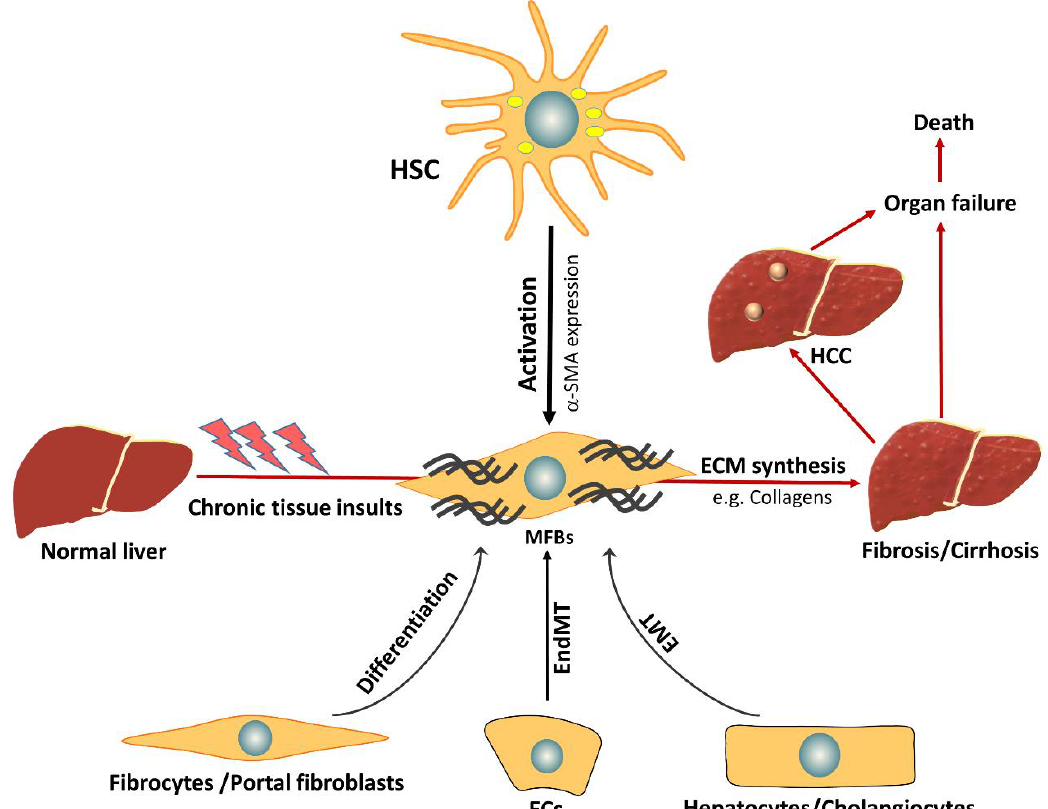
Figure 1. Activation of hepatic stellate cells (HSCs) and origin of myofibroblasts (MFBs) in chronic liver diseases. During activation, HSCs lose intracellular lipid droplets, acquire a fibroblast-like shape, and express a large amount of alpha-smooth muscle actin ( α -SMA) and extracellular matrix proteins (ECM). Beside HSCs, which represent a major source of MFBs, other cells such as pericytes, portal fibroblasts can di ff erentiate into MFBs. Also, endothelial cells (ECs) and epithelial cells, i.e., hepatocytes and cholangiocytes, might contribute to liver MFBs pool through an endothelial-mesenchymal transition (EndMT) and epithelial-mesenchymal transition (EMT), respectively. However, unequivocal in vivo evidence of EMT during liver fibrosis is still missing.